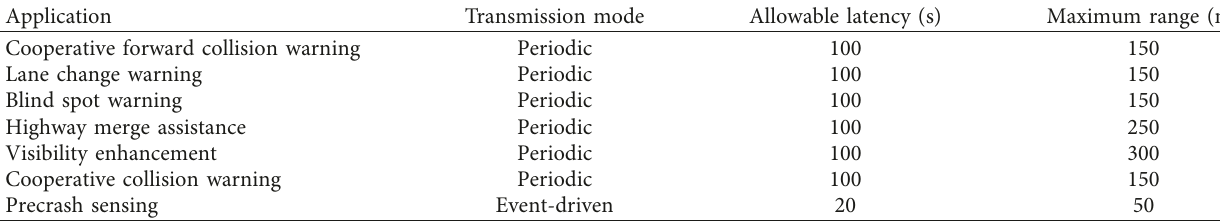
Table 1: Safety applications and their